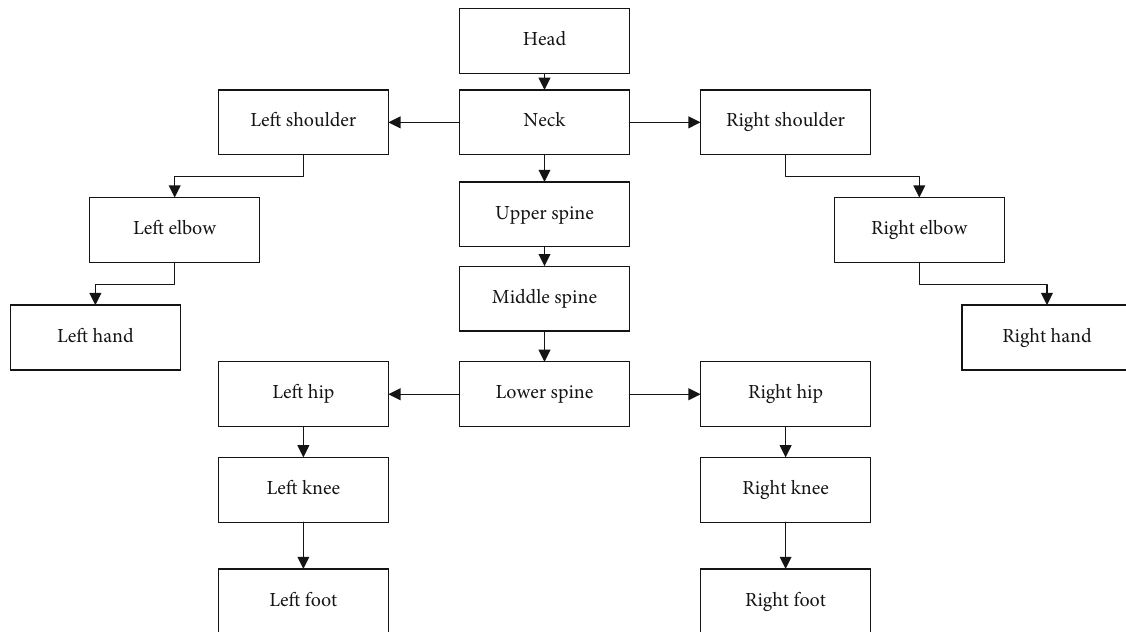
Figure 4: Joint points after skeleton identi fi